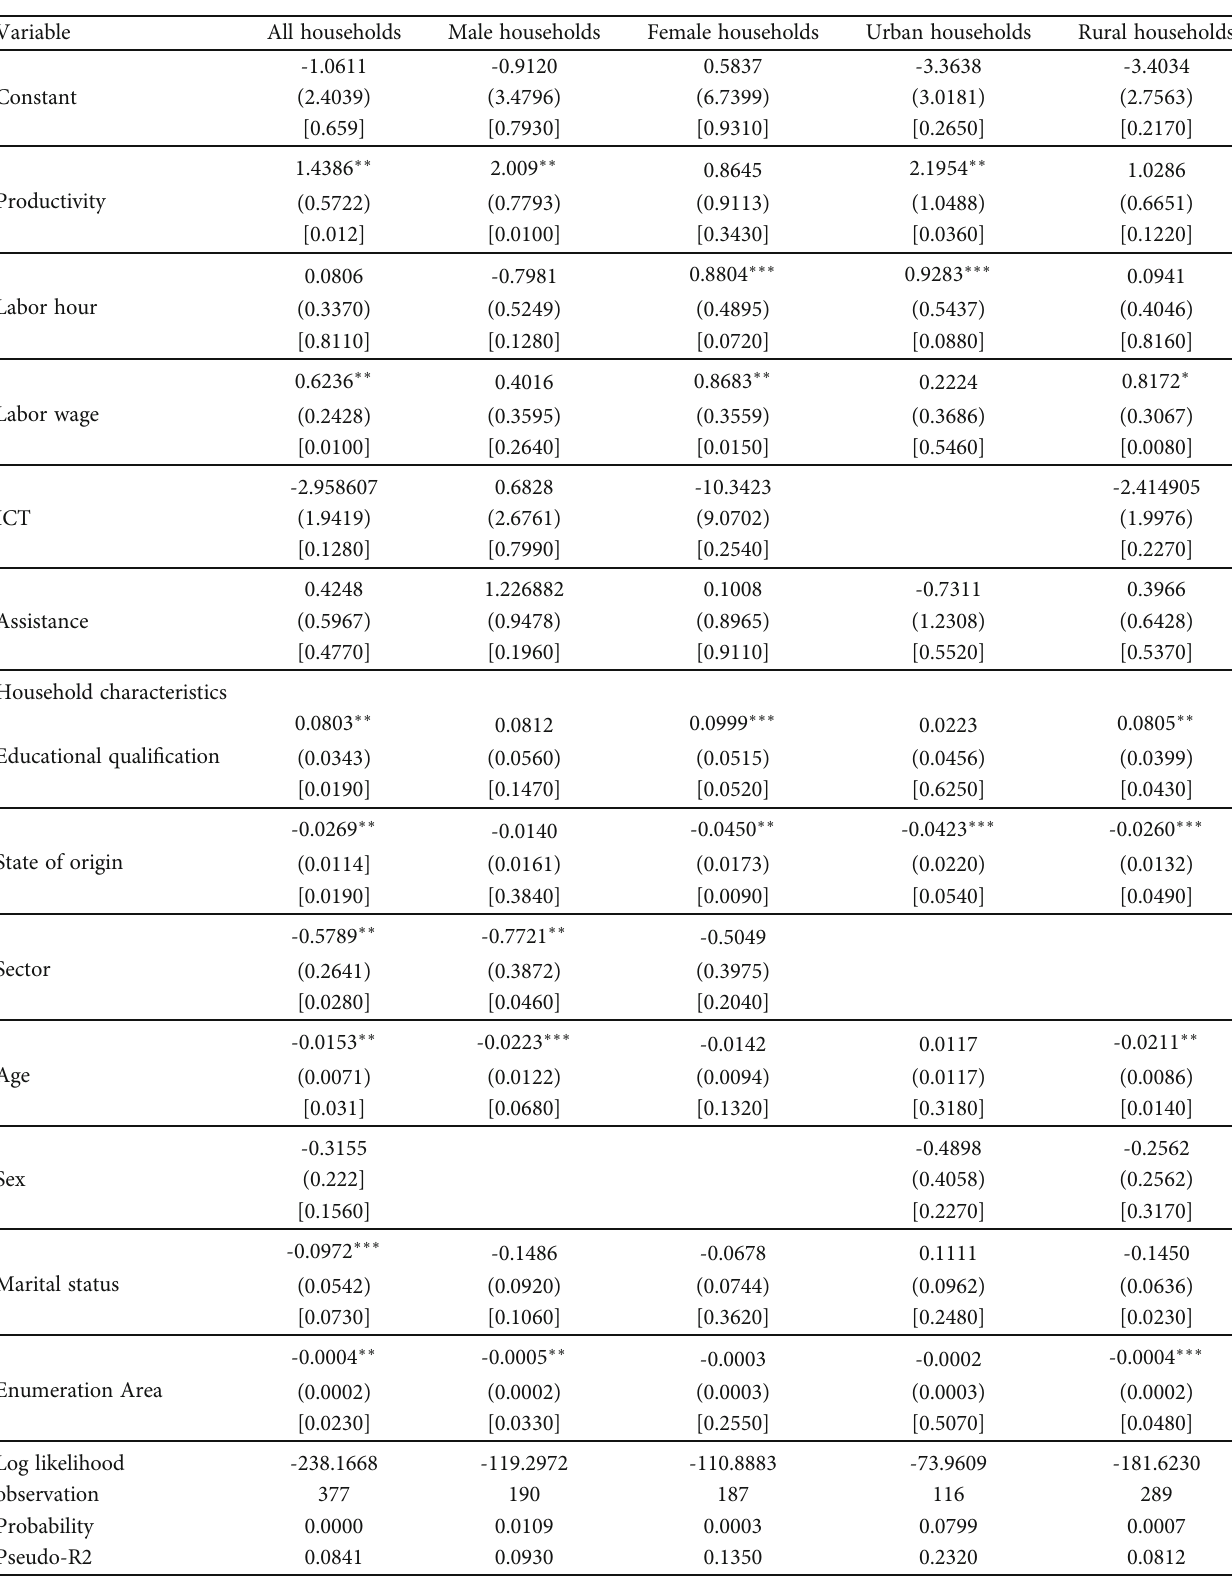
Table 4: Logit regression estimates (outcome variable: food